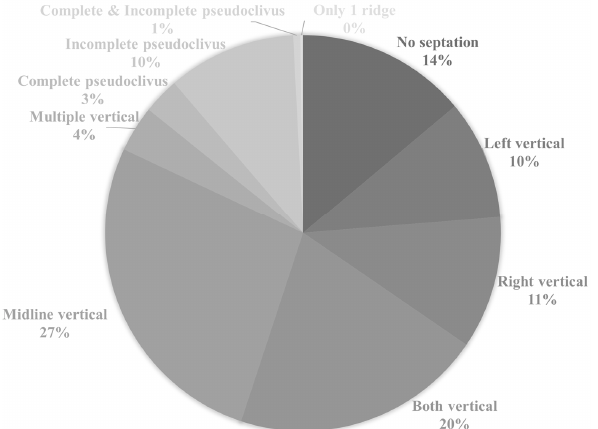
Figure 2. Classification of intersphenoid sinus septation based on preoperative paranasal sinus computed tomography scan. The classification of intersphenoid sinus septation also depends on the presence/absence of another vertical intersphenoid sinus septum or ridge.